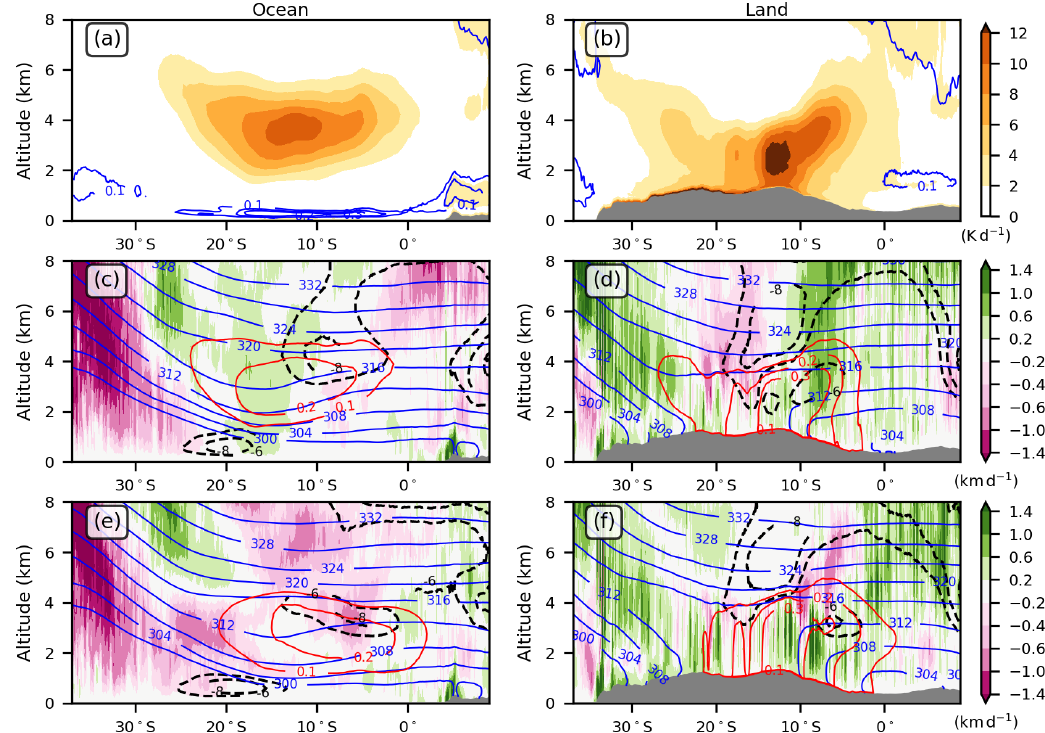
Figure 9. (a–b) Radiative heating (Kd − 1 , shading) and cloud fraction (blue contour) from the BBRAD ensemble mean. (c–f) Vertical wind (ms − 1 , shading), zonal wind (ms − 1 , black contours when lower than − 6ms − 1 , dotted when lower than − 10ms − 1 ), potential temperature (K, blue contours) and aerosol extinction (km − 1 , red contours) from the (c–d) BBRAD and (e–f) NORAD ensemble means. Fields are averaged at 12:00UTC between 8 and 16 September 2017 as well as (a, c, e) between 5 and 10 ◦ E and (b, d, f) between 15 and 25 ◦